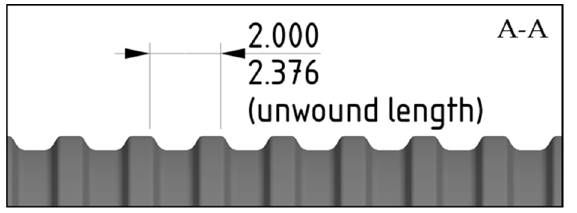
Figure 6. Sketch of the flow field with groove spacing and unwounded length.